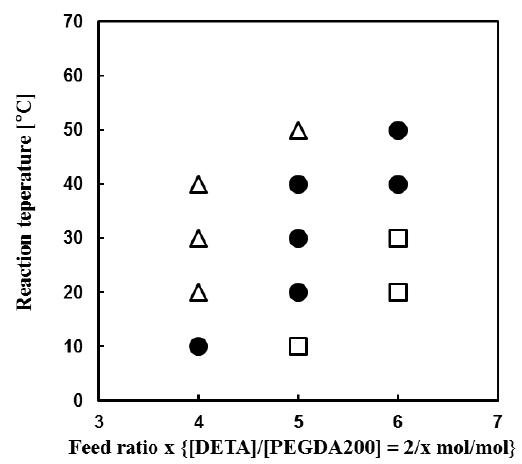
Figure 6. Production diagram of DETA-PEGDA200 reaction system in EtOH, monomer concentration in reaction solution: 20 wt%, △ gel, ● porous polymer, □ precipitate.